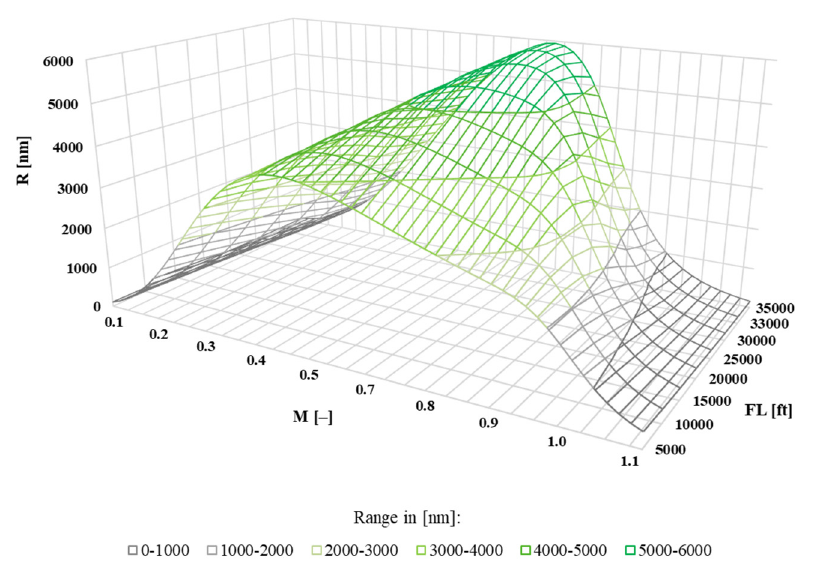
Figure 6. 3D plot visualizing the influence of altitude and Mach on range with transonic wave drag model.